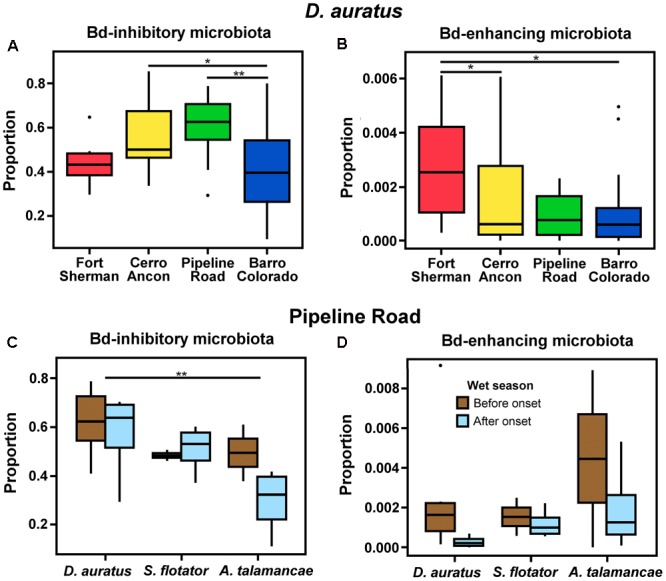
Proportions of Batrachochytrium dendrobatidis (Bd) inhibitory (A) and enhancing (B) microbiota in D. auratus across sites in central Panama, arranged in order of increasing average soil pH values (A,B), and in relation to the onset of the wet season in three Panamanian dendrobatoid frog species at Pipeline Road (C,D).